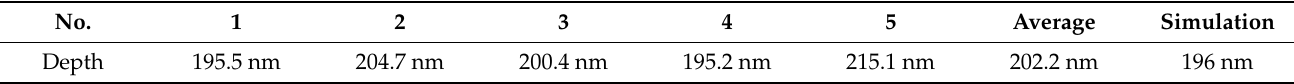
Figure 7. Two − dimensional lattice temperature. Table 2. The ablation depths of experiment and simulation.